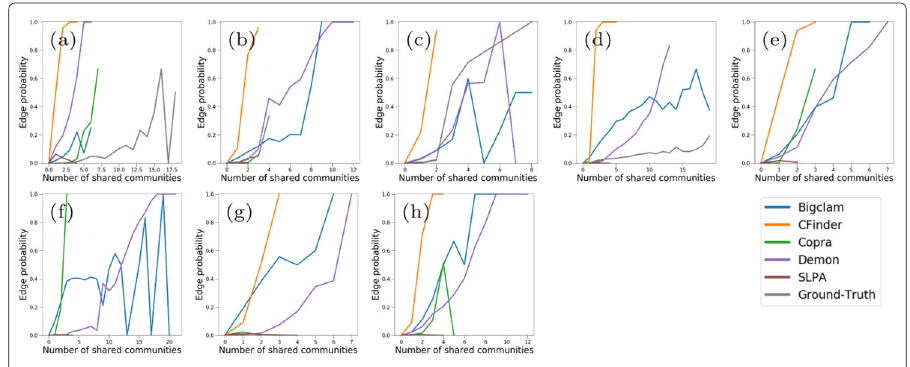
Fig. 7 Edge probability of the nodes identified by the methods considering the real-world networks: a Amazon; b DBLP; c LiveJournal; d Youtube; e CAGrQc; f CAHepPh; g Email; h Keys